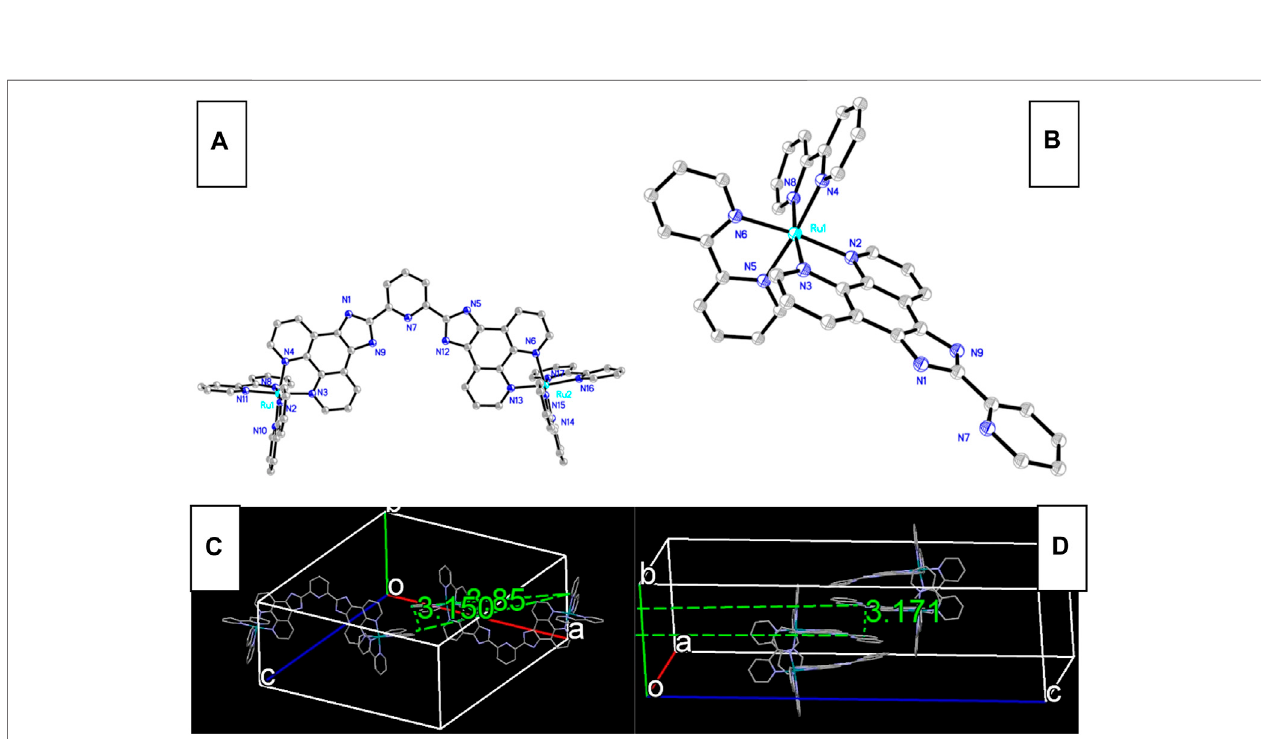
FIGURE 1 | Single-crystal structure of Ru-1 (A) and Ru-3 (B) , and their packing mode [ (C) for Ru-1 and (D) for Ru-2].